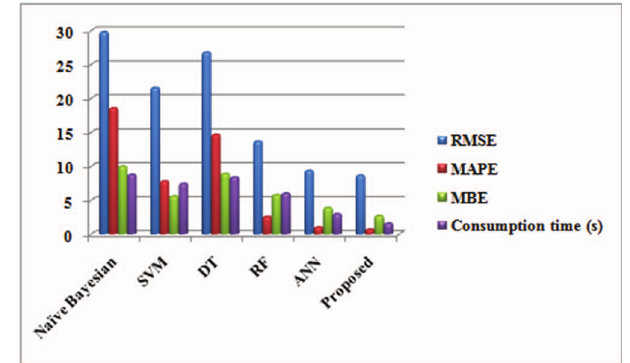
Fig. 21. Statistic evaluation of proposed using existing system through island for 100